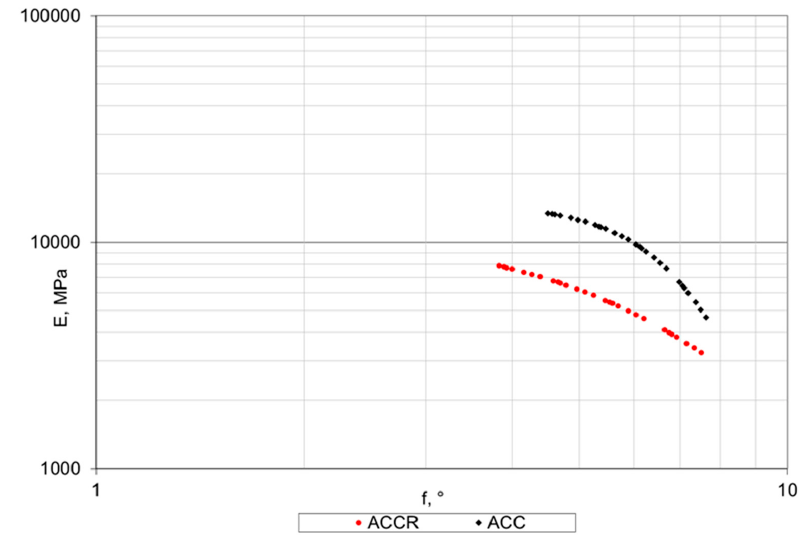
Figure 14. Black plot of stiffness modulus E vs. phase shift angle φ for ACC with 20% of “B” CSR mortar and ACC with 20% cement-sand mortar (C:S = 1:1).